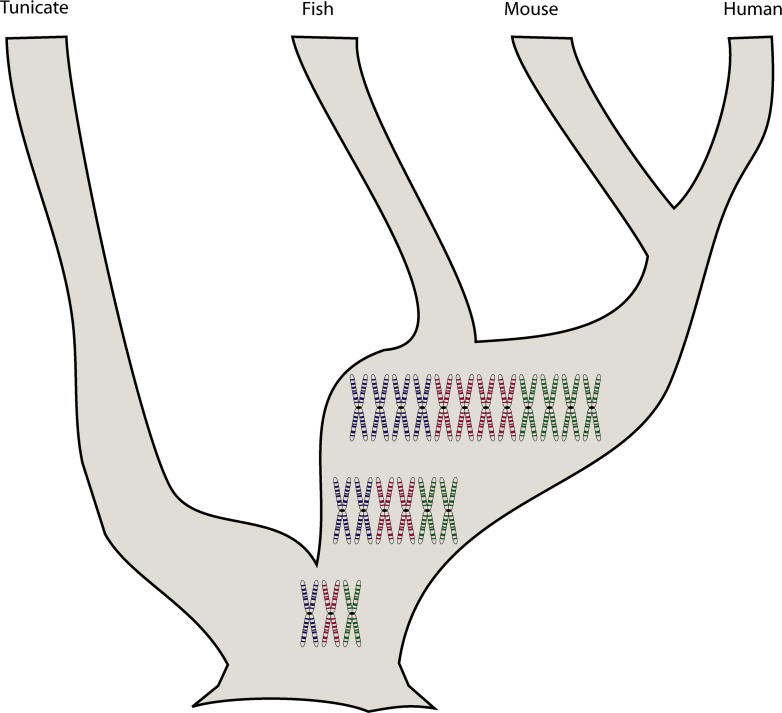
The evolutionary patterns of gene duplications were reconstructed by comparing the complete gene sets of a tunicate (sea squirt), fish, mouse, and human. The 4-fold pattern in their global physical organization provides unmistakable evidence of two distinct, ancient whole genome duplications